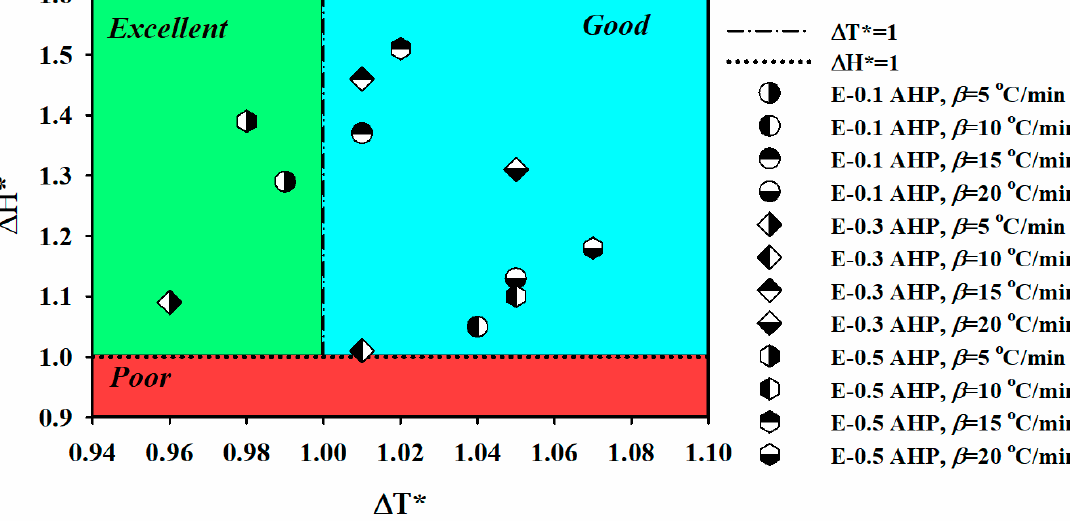
Figure 4. Graphical representation of cure state of epoxy nanocomposites, ∆ H * and ∆ T * are dimensionless enthalpy and temperature interval for the complete curing process.